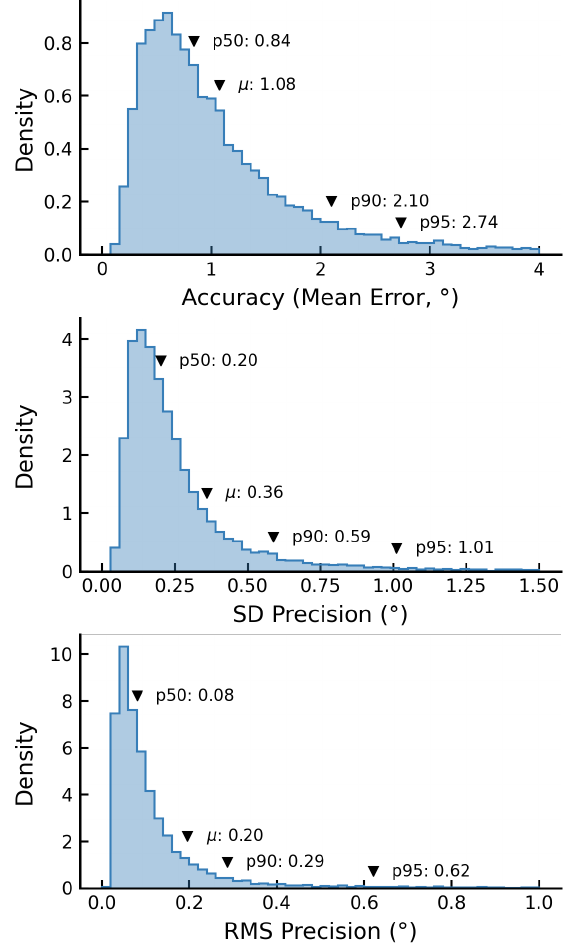
Figure 3. Frequency density histograms of accuracy and preci- sion metrics across all validation trials (combined gaze). Top: Accuracy (average absolute error relative to target), Middle, Bottom: Precision (standard deviation and inter-sample root mean square error of gaze angles). Histograms are based on fixations to all presented target positions. Means and percentiles for each measure are annotated to allow direct comparison with device specifications. Data computed before outlier correction. Note: Plots are truncated at a specific x value (4°, 1.5°, and 1°, respectively) to better visualize the overall distributions and